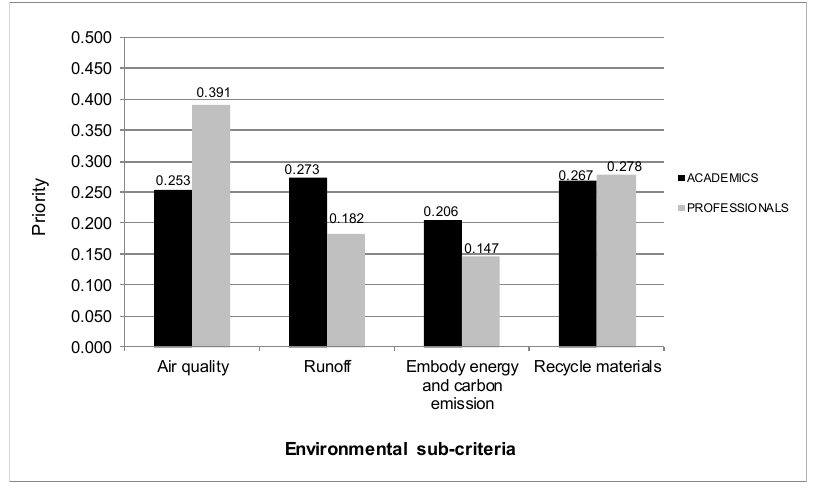
Figure 5. Priorities assigned to “Environmental” sub-criteria by Academics and Professionals.